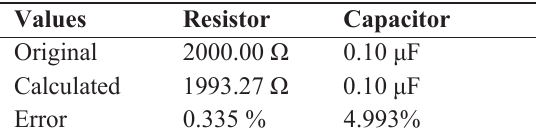
Table 4: Comparison of actual impedance data and the data obtained from LEBISDI for RCM 2 containing a 2 kΩ resistor and a 0.1 μF capacitor in parallel.